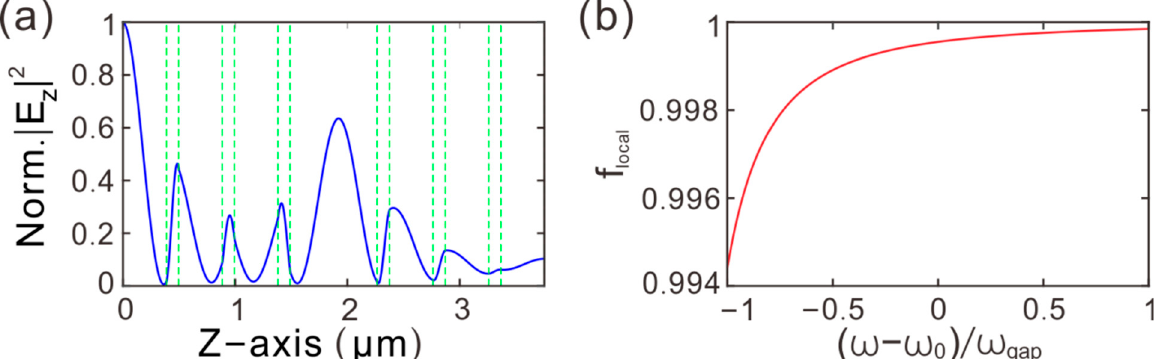
Figure 7. ( a ) Distribution of electric field of the defect mode. Transmission spectra for different values of the incident angle. ( b ) Local field correction factor changing with the normalized frequency. The incident angle is θ = 20°.